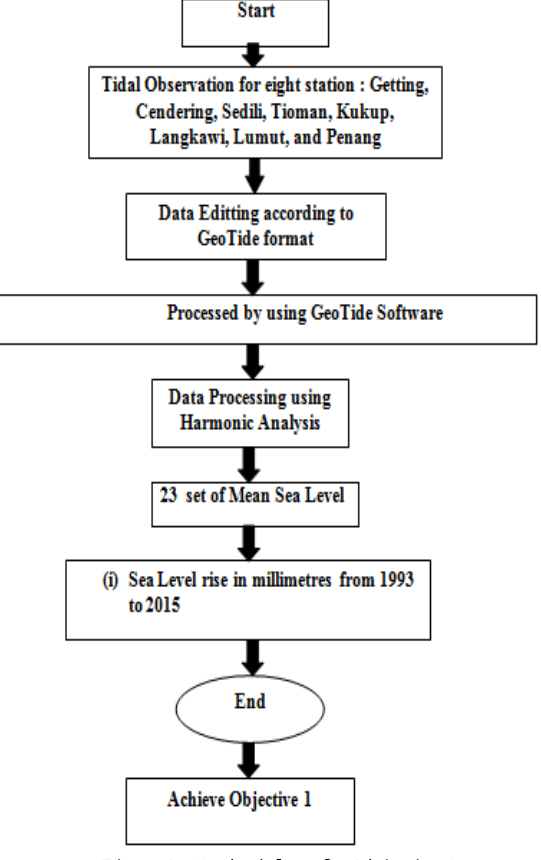
Figure 3. Methodology for Objective